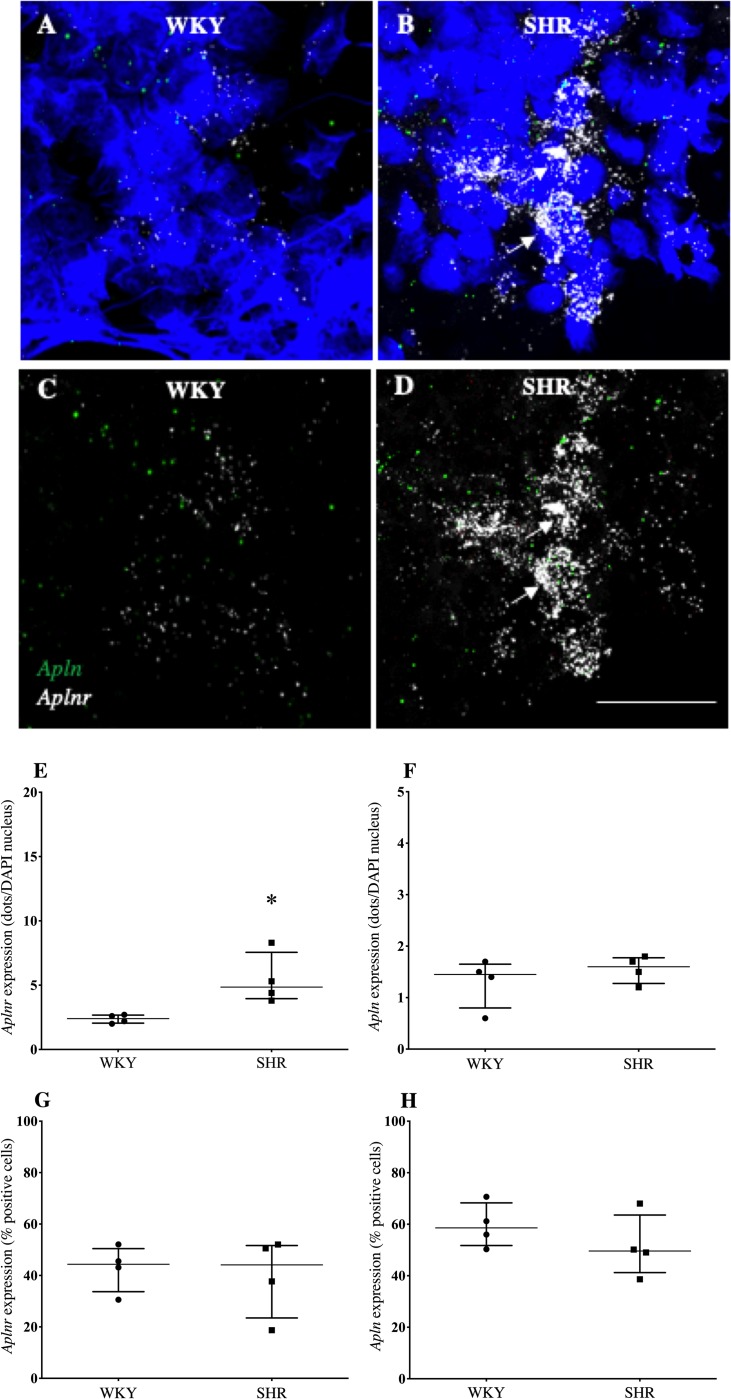
Aplnr and apln expression in the SFO of WKY rats and SHRs.(A-D) Representative fluorescent images showing expression of aplnr and apln in the SFO of WKY rats (A and C) and SHRs (B and D). DAPI: blue, aplnr: white, apln: green. DAPI removed from C and D to highlight distribution of mRNA. Arrows point to representative cells with relatively high levels of aplnr expression. Scale bar = 50μm. (E-H) Graphs showing gene expression as a function of dots/DAPI nuclei or percentage positive cells for aplnr (E and F) and apln (G and H) expression. n = 4/group. Data is median [IQR]. *p<0.05.